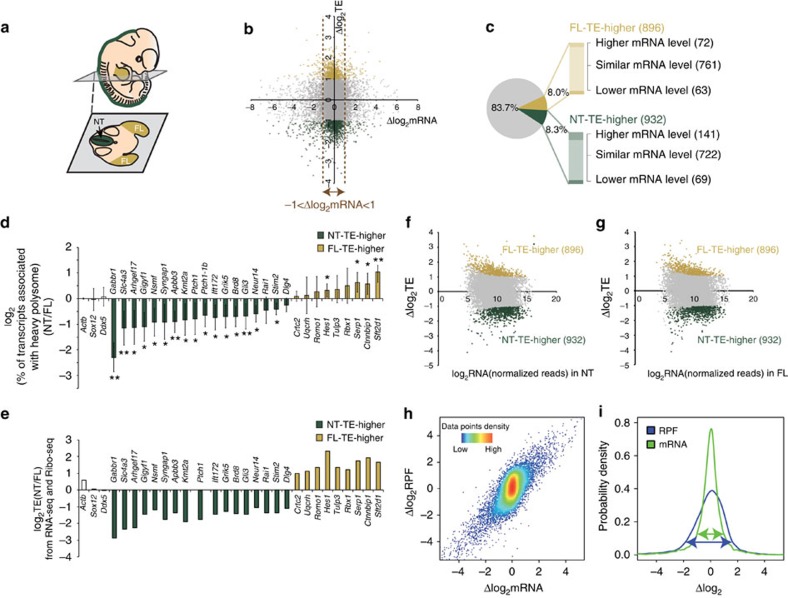
Snapshots of translational landscapes of developing mammalian embryos reveal dynamic translational control of signalling between tissues.(a) Schematic illustration of an E11.5 embryo. The neural tube (NT), in dark green, and forelimb (FL), in yellow, were microdissected and assessed for differences in translational efficiency (TE) at a genome-wide level by Ribo-Seq and RNA-Seq. (b) Scatter plot of Δlog2 in TE over Δlog2 in mRNA between the NT and FL. NT-TE-higher and FL-TE-higher are genes with significantly higher TE in NT (FDR<0.2 and Δlog2TE<−1) or higher TE in FL (FDR<0.2 and Δlog2TE>1), respectively. The vertical dash lines mark the region with no significant change in the mRNA levels in between (−1<Δlog2 mRNA<1). (c) Pie chart shows the number and percentage of genes having higher TE in the FL (yellow), higher TE in the NT (dark green) and no significant difference in TE (grey). Genes with distinct TEs are further divided according to the changes in the mRNA levels, shown in the column chart. (d) log2 change in the percentage of mRNAs associated with actively translating polysomes determined by quantifying mRNA in the heavy polysome fractions and normalized by its total. Ptch1-1b represents the predominant isoform of Ptch1 in both in NT and FL (Supplementary Fig. 8), identified by 5′RACE. Error bars represent s.d. (t-test, **P<0.01; *P<0.05, n≥5). (e) Δlog2TE between NT and FL from Ribo-Seq and RNA-Seq analysis. (f,g) Scatter plot of Δlog2TE between tissues over the mRNA abundance (log2mRNA(normalized reads)) in (f) NT and (g) FL. (h) Shown is the distribution of Δlog2 in RPFs over the Δlog2 mRNA between NT and FL at E11.5. (i) Comparison of the probability density distribution of Δlog2 in mRNA (green) and RPFs (blue) reveals a significantly greater change in the RPFs than mRNAs between the tissues. (b–i) Colour key: higher TE in the FL (yellow), higher TE in the NT (dark green) and no significant difference in TE (grey).